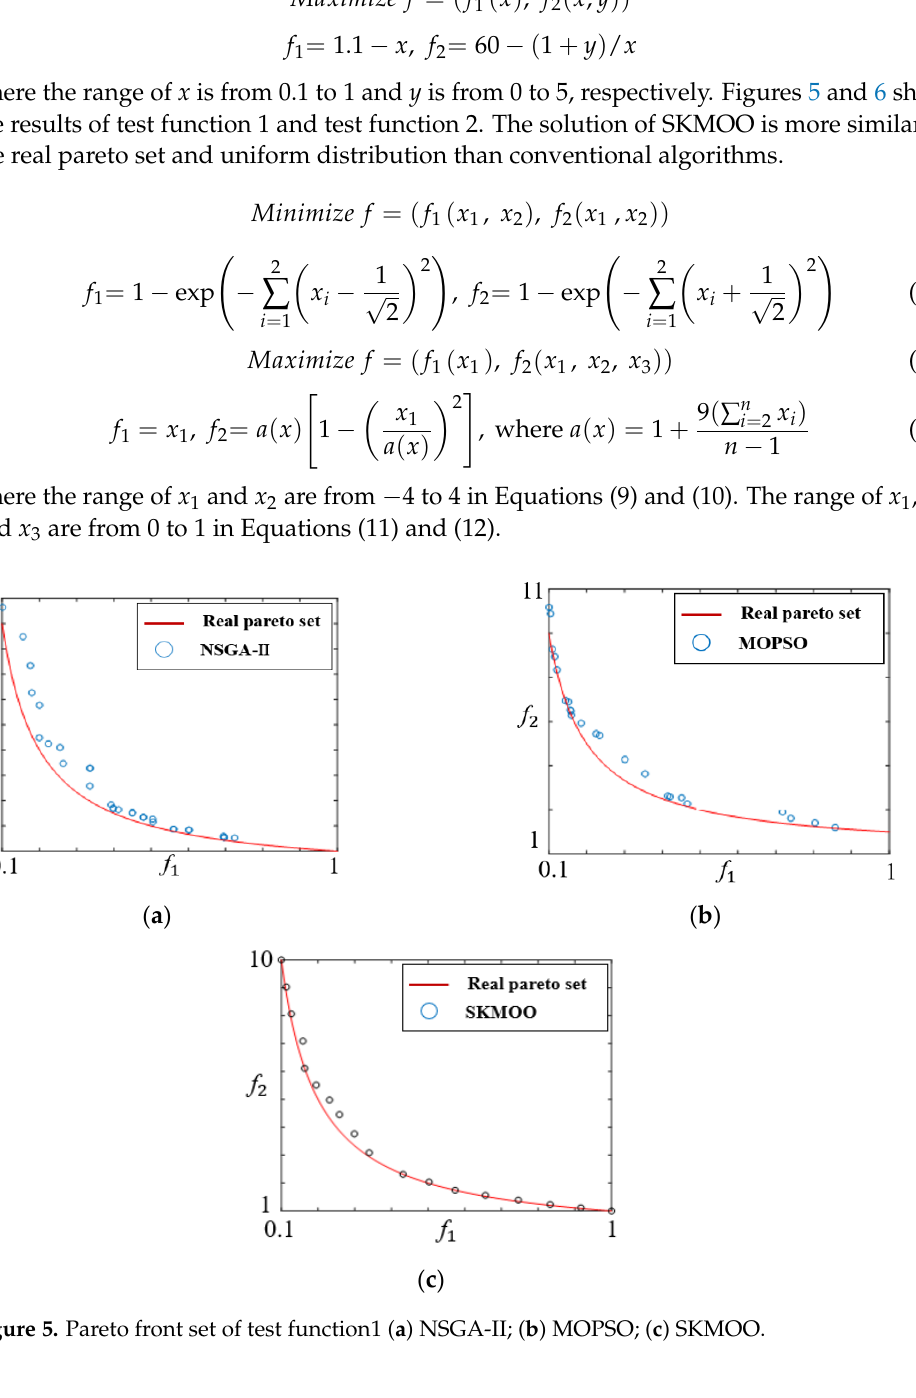
( c ) Figure 6. Pareto front set of test function2 ( a ) NSGA-II; ( b ) MOPSO ; ( c ) SKMOO. Minimize f = ( 𝑓 (cid:2869) ( 𝑥 (cid:2869) , 𝑥 (cid:2870) ), 𝑓 (cid:2870) ( 𝑥 (cid:2869) , 𝑥 (cid:2870) ))